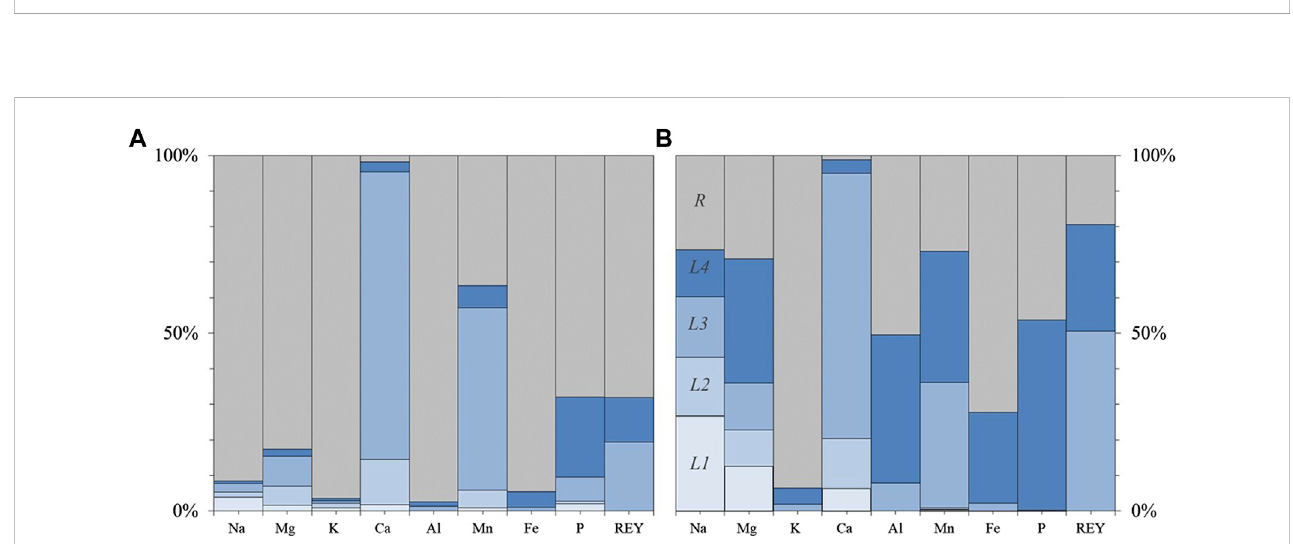
FIGURE 6 Extraction yield andcontribution of leachates (blue vertical bars) andresidual(grey bars) fractions oftotal REY andrelated major element concentrations intheGroupIatJOSAN (A) andGroupIVatJOEP (B) .LeachatewithMilliQwater(L1);leachatewith0.05NHac(L2),leachatewith1NHCl(L3);leachatewith2N HNO 3 (L4); residual fraction